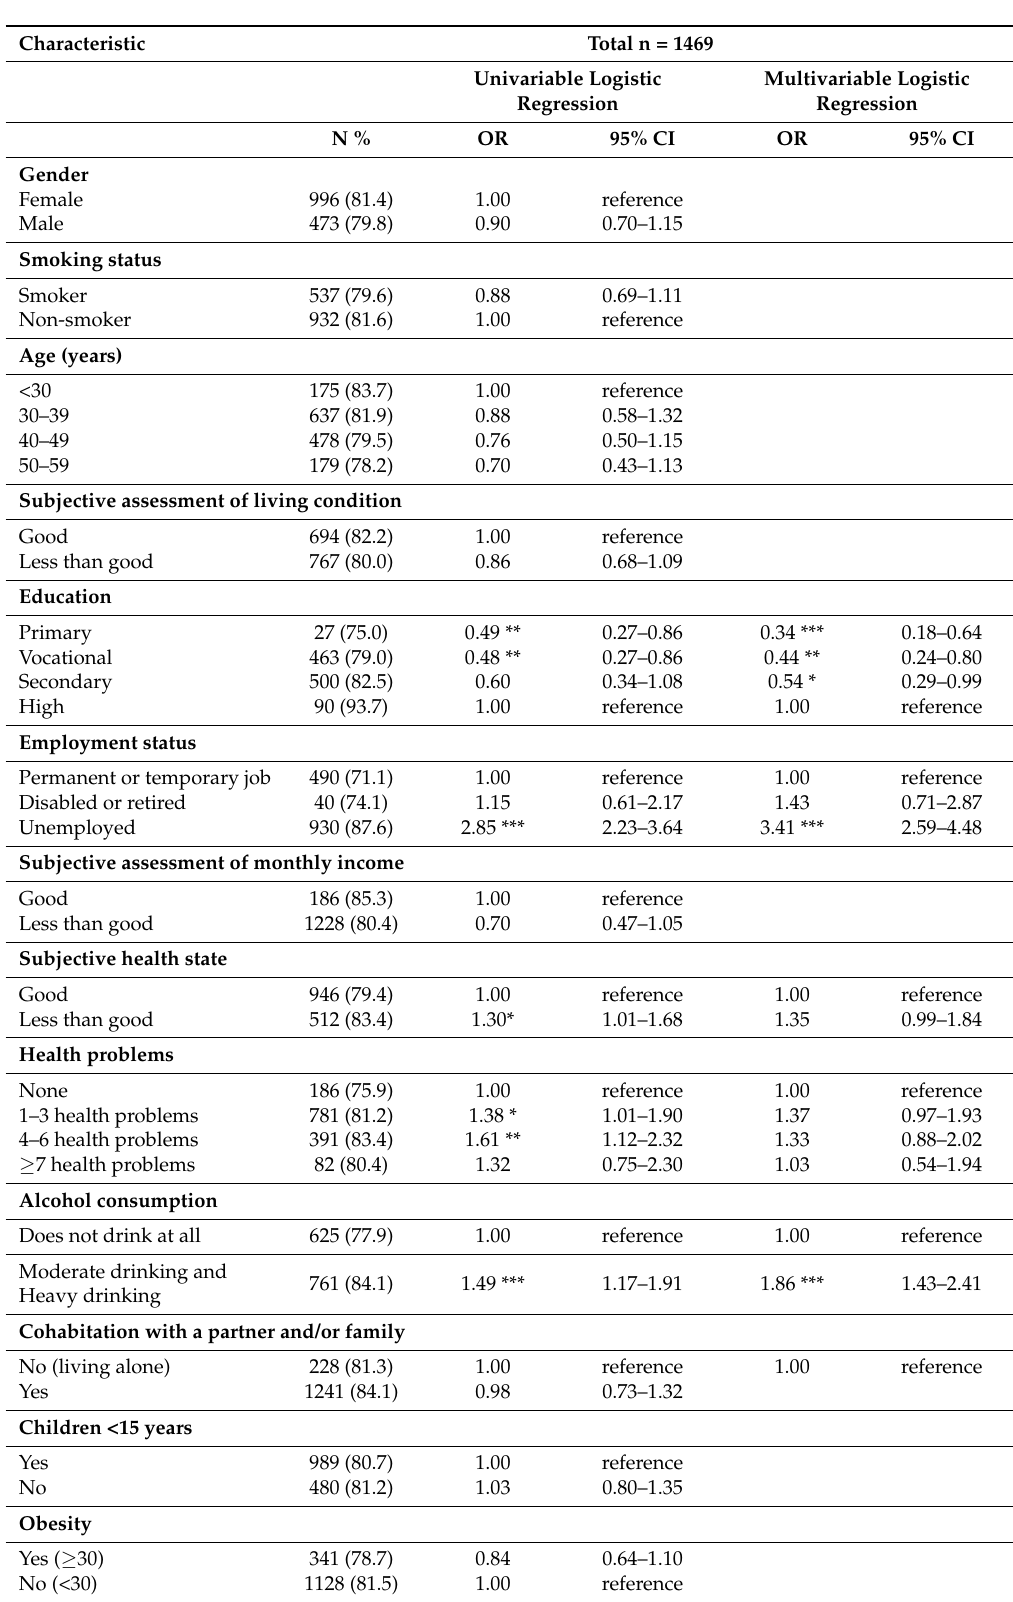
Table 4. Odds ratio (OR) and 95% confidence interval (CI) for inactivity during commuting by socio-demographic